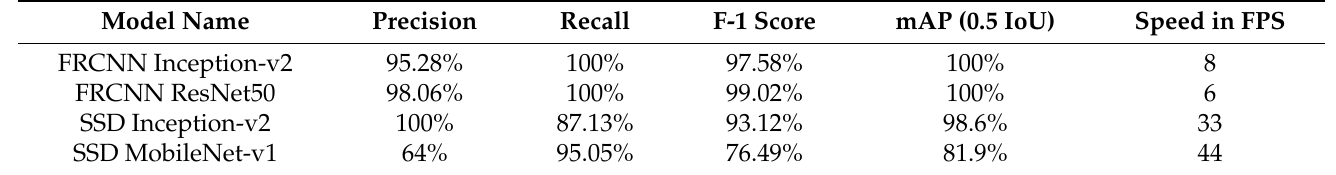
Table 3. The performance of various object detection models for OSU thermal test dataset.